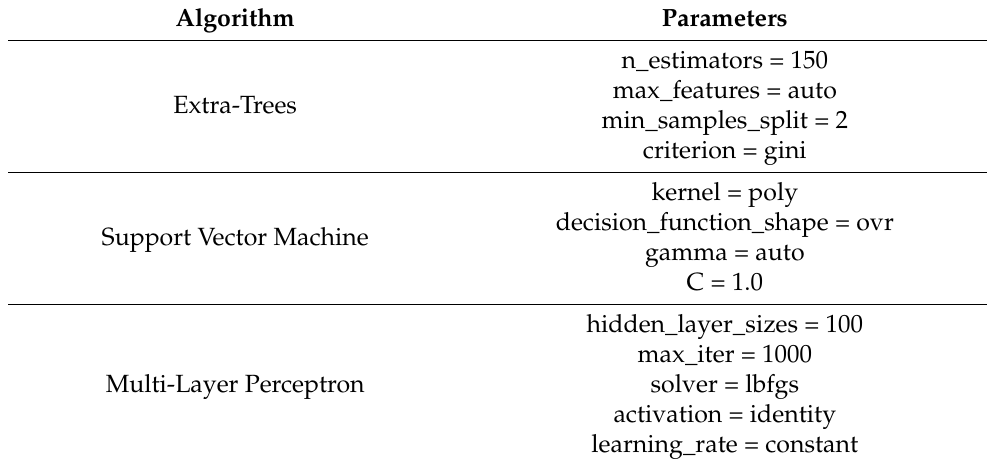
Table 3. Parameters acquired by the grid-search approach for training the